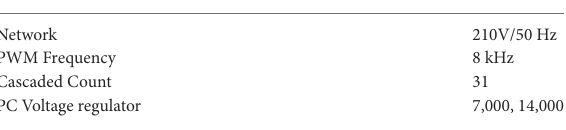
TABLE 1 Simulation parameters.